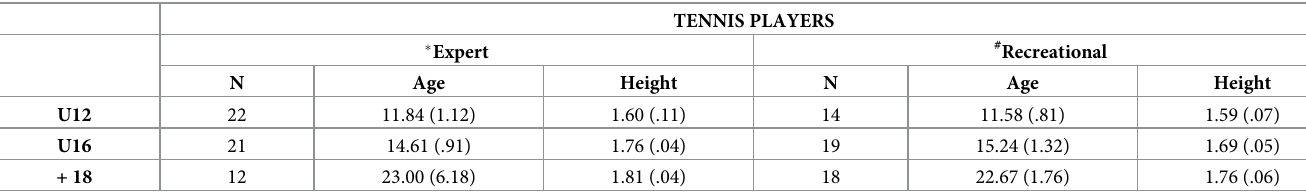
Table 1. Demographic information from the participants who took part in the